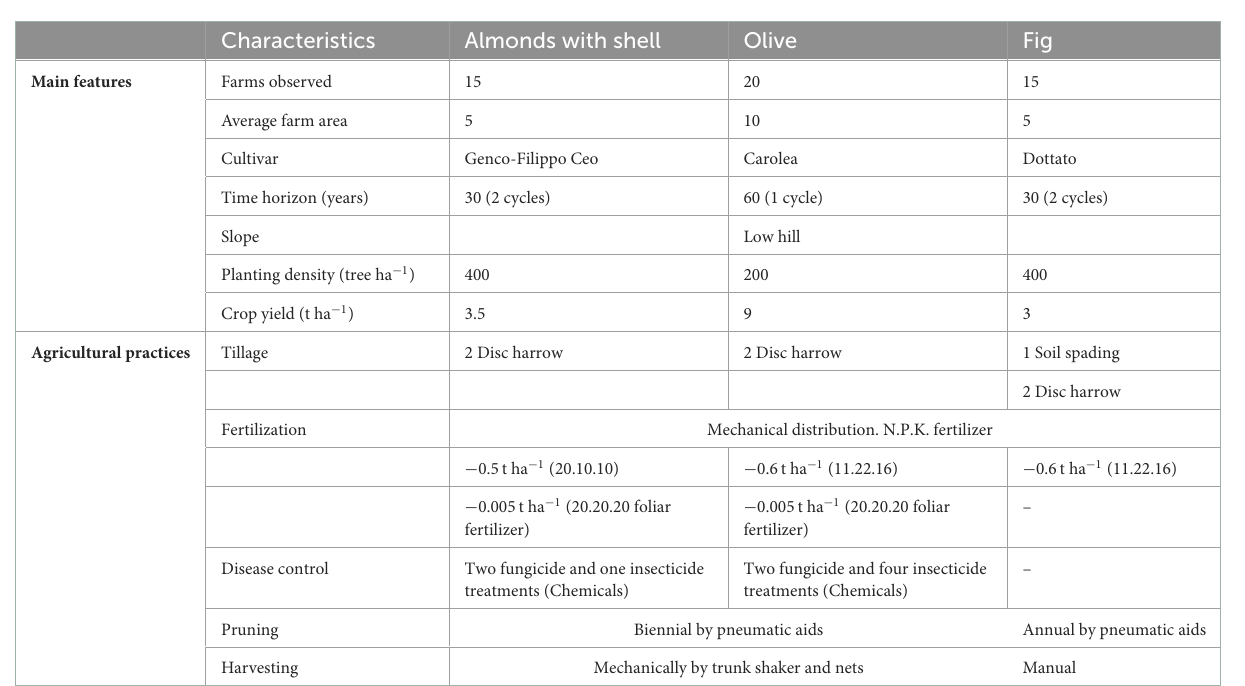
TABLE 2 Crop scenario